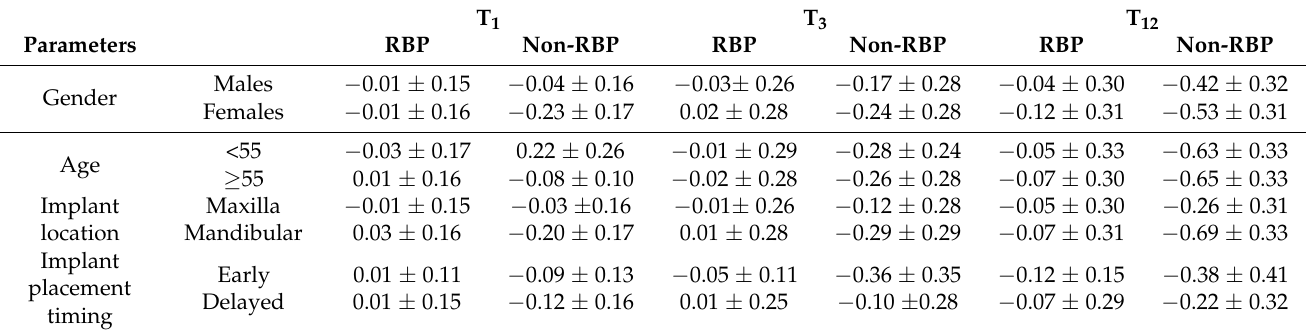
Table 5. Mean ± SD values of the Bone loss Area at 1, 3 and 12